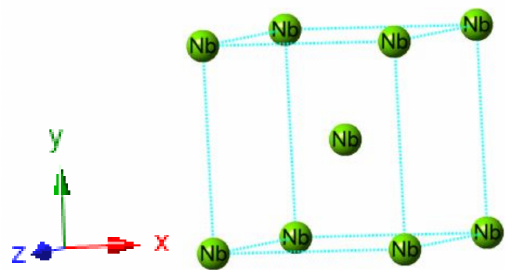
Figure 7. Crystalline structure (bbc) of the metal Niobium (adapted from [32]). Niobium can be present in different compounds such as carbide, hydride, and oxides. There are three groups of anhydrous Niobium oxides: NbO, NbO 2 , and Nb 2 O 5 . In Figure 8, we show the unit cells of the cubic NbO and tetragonal NbO 2 compounds [45].